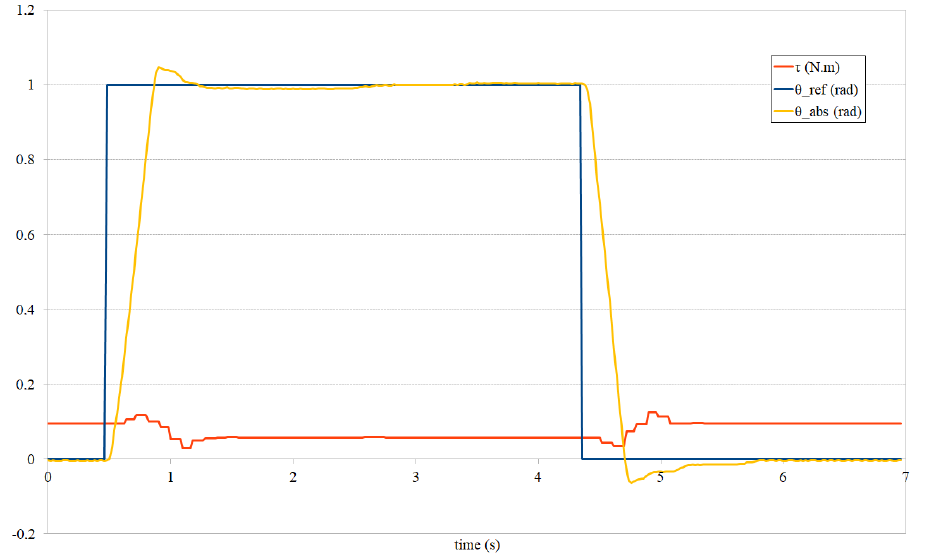
Figure 15. Change in position reference with compliant controller.